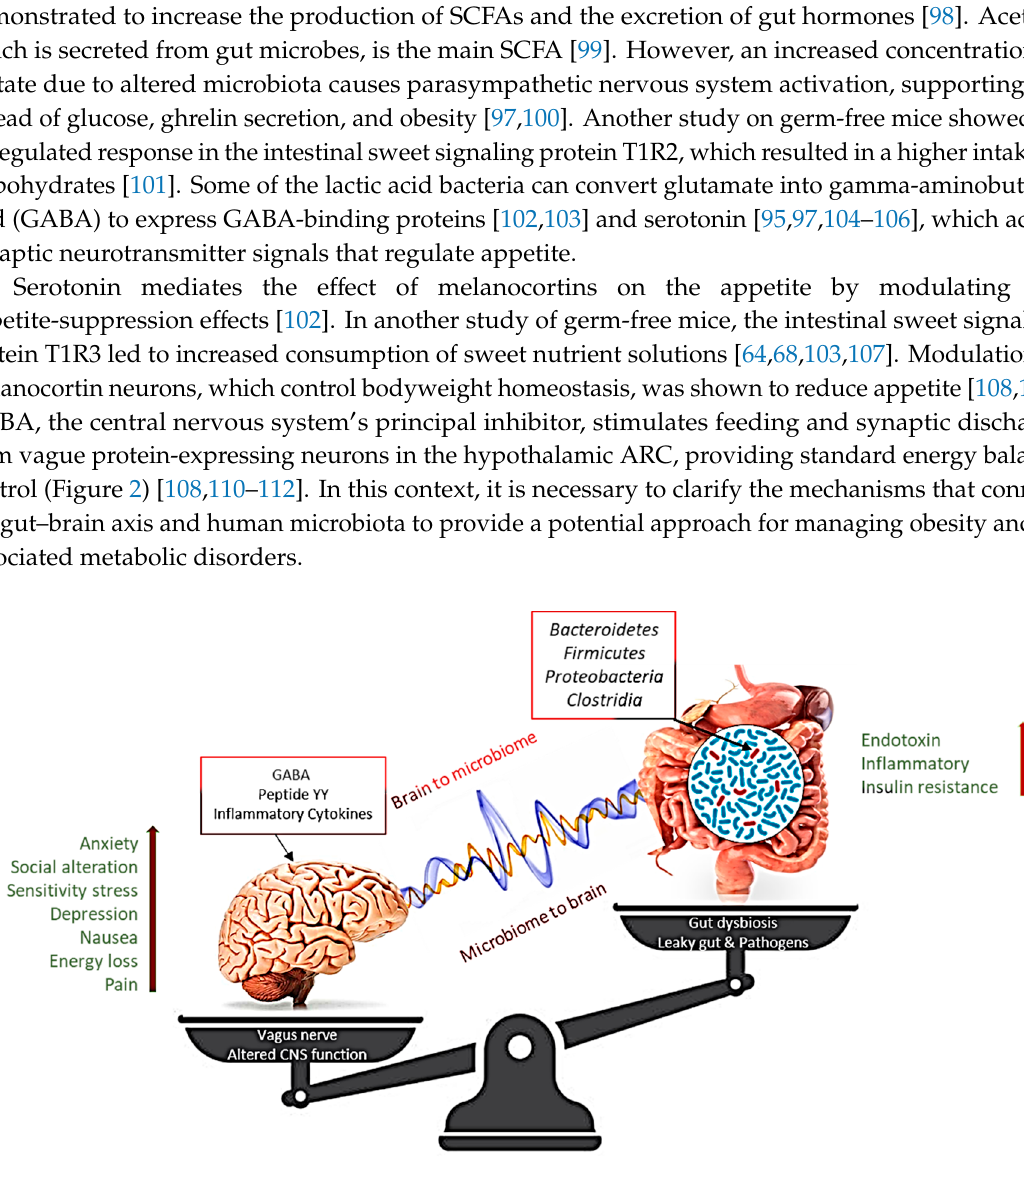
Figure 2. Altering microbiota show that intestinal dysbiosis can adversely affect human physiology, causing improper signaling of the intestinal brain axis and associated effects on central nervous system (CNS) functions, resulting in obesity. In contrast, stress at the CNS level can influence gut function and lead to microbiota disturbances. GABA, gamma-aminobutyric acid. The [Right arrow] indicate gradual increase in Endotoxin, Inflammatory and Insulin resistance, which is correlated with the enhanced level [Left arrow] of Anxiety, social alteration, Sensitivity stress Depression, Nausea, Energy loss and pain.